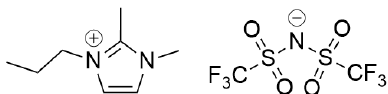
Figure 1. Chemical structure of 1,2-dimethyl-3-propylimidazolium bis(trifluoromethylsulfonimide)